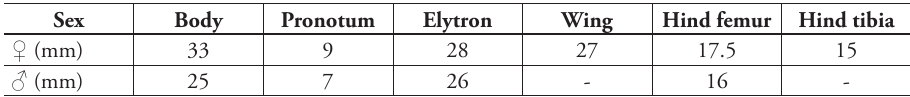
11 lateral view of head & pronotum 12 antenna 13 dorsal view of pronotum 14 dorsal view of base of hind Table 1. Measurements (in mm) of female Pycnodictya galinieri galinieri from Egypt (male after Saussure 1884).